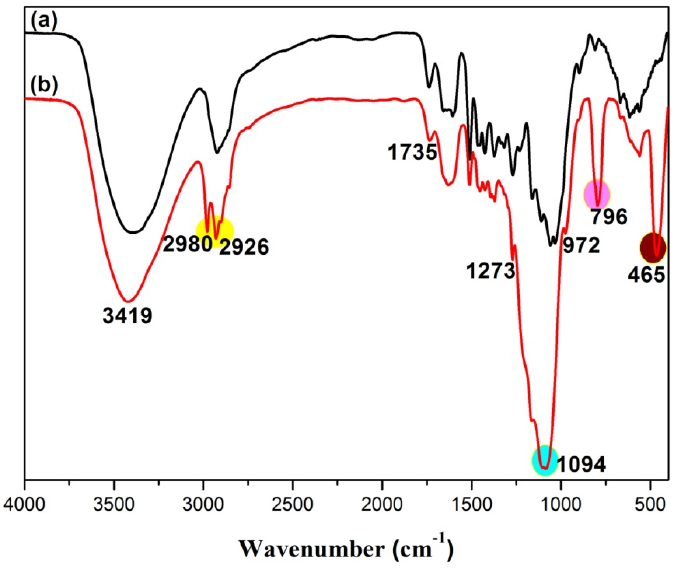
Figure 3. FTIR spectra of the original wood sample and the wood sample treated with the SiO 2 /PMHOS solution (( a ) original wood; ( b ) modified wood).